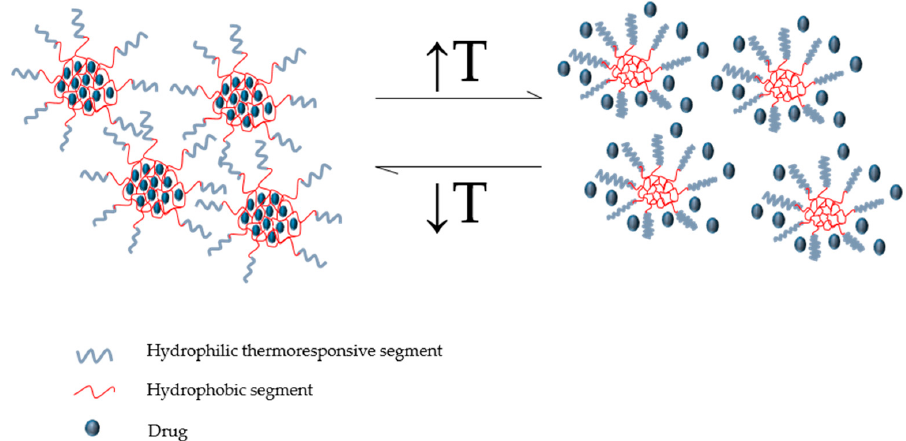
Figure 1. Conceptual illustration representing the drug release mechanism of a thermoresponsive micellar system with a lower critical solution temperature (LCST) (outer shell: thermoresponsive segments, inner core: hydrophobic segments). (Source: de Oliveira et al. [29]. Licenced under a Creative Commons Attribution